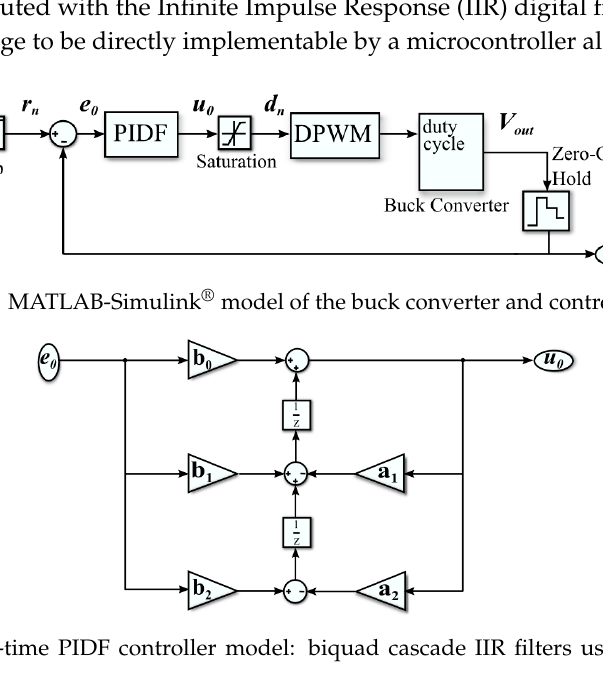
Figure 8. Simulated control signal, inductor current and output voltage under step variation of the reference value from 0 V to 12 V using the proposed control method. An experimental hardware device has been built to verify the proposed method for the DC-DC buck converter. It is composed by the buck converter and an Arduino Due development board, based on a 32-bit Atmel SAM3X8E ARM ® Cortex ® M3 CPU, see Figure 9. The main components of the buck converter circuit have been selected as shown in Table 1. Figure 9. Physical realization of the buck converter. An interrupt routine is generated every T s = 5 × 10 −5 s . This routine starts the ADC conversion of the output signal of the converter and computes the duty cycle of the PWM control signal. Figure 10